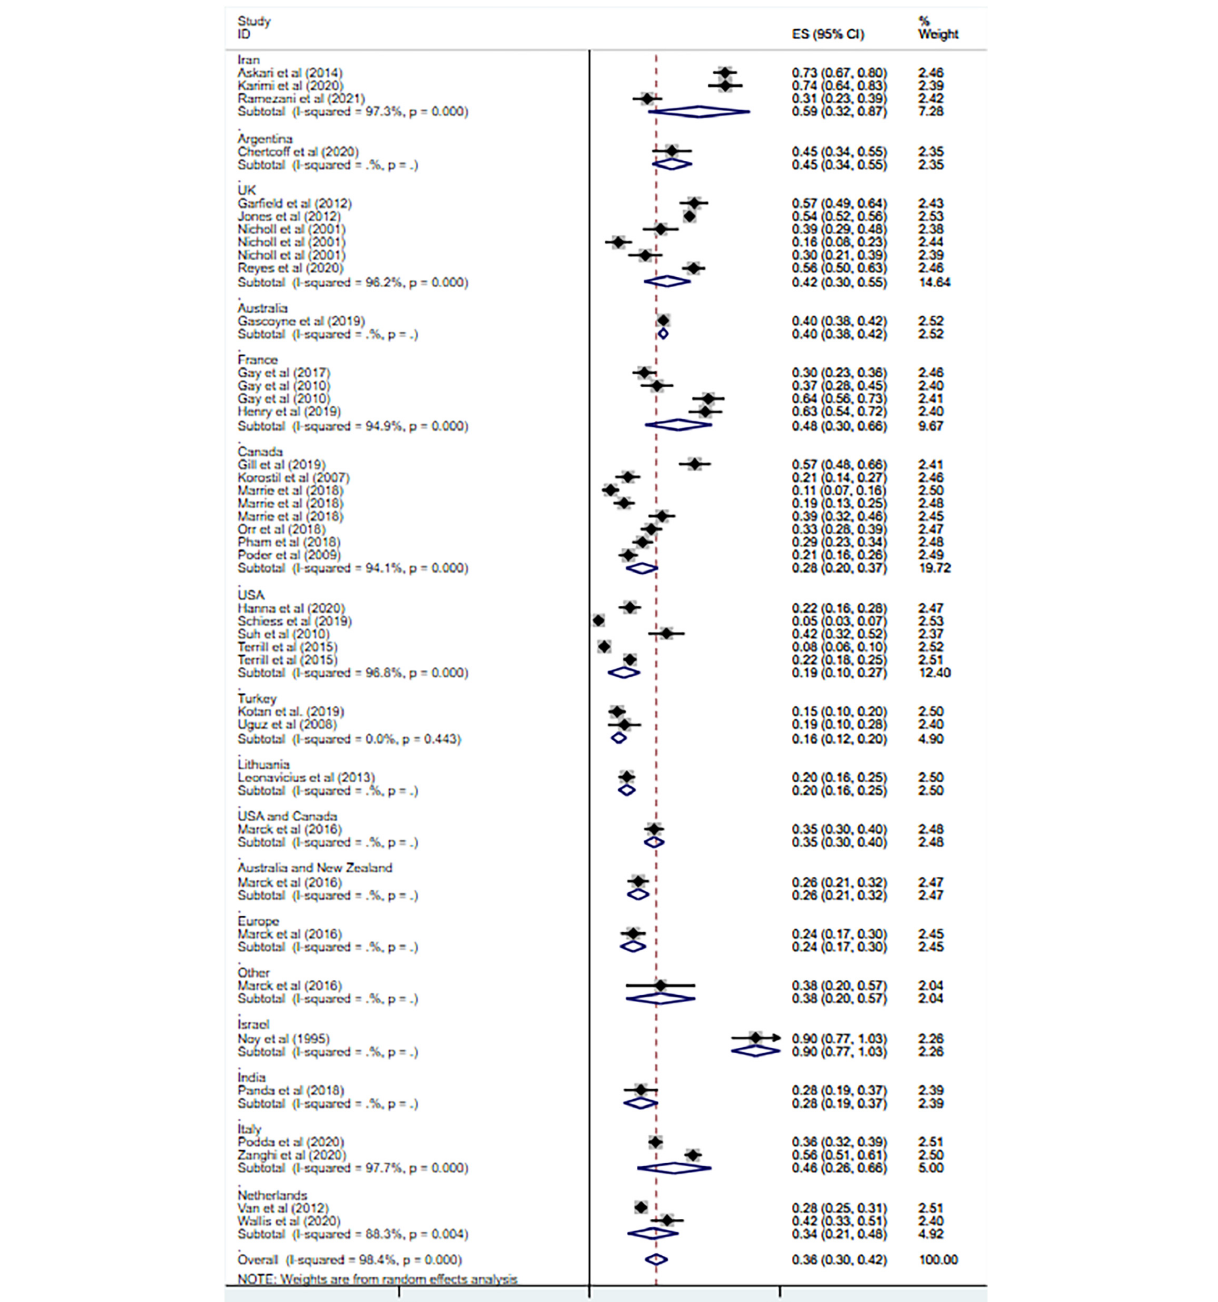
FIGURE3 Forest plot of subgroup analysis on changes of prevalence of anxiety in MS based on country.